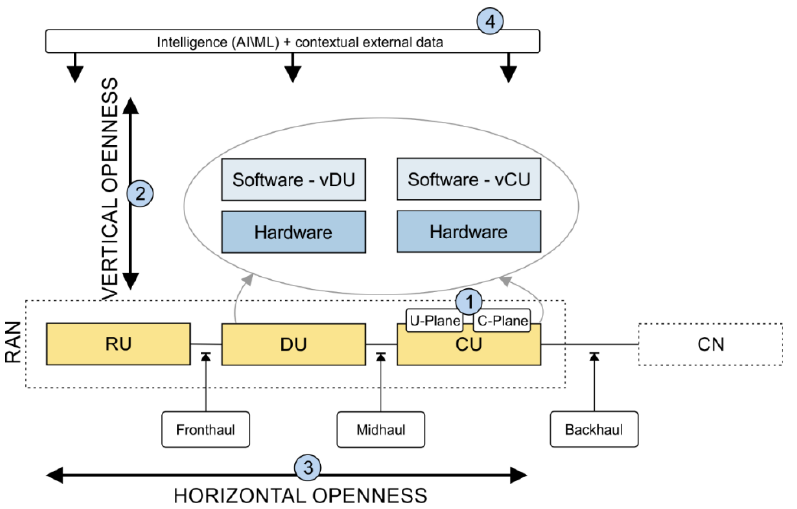
Figure 3. Four dimensions of openness and disaggregation: (1) User and Control Plane separation; (2) Vertical openness enabling shifts bare-metal deployment to towards HW and SW disaggregation; (3) Horizontal openness thanks to open interface standardization; (4) ML approach instead of software developed in a static way.